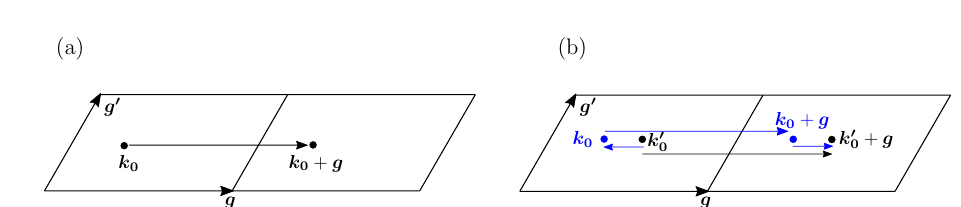
Figure 7: Paths in the BZ for a Wilson loop. (a) The simplest nontrivial closed path given in Eq. (108), winding once and parallel to a primitive reciprocal lattice vector g . (b) A simple nontrivial path k path with basepoint at k